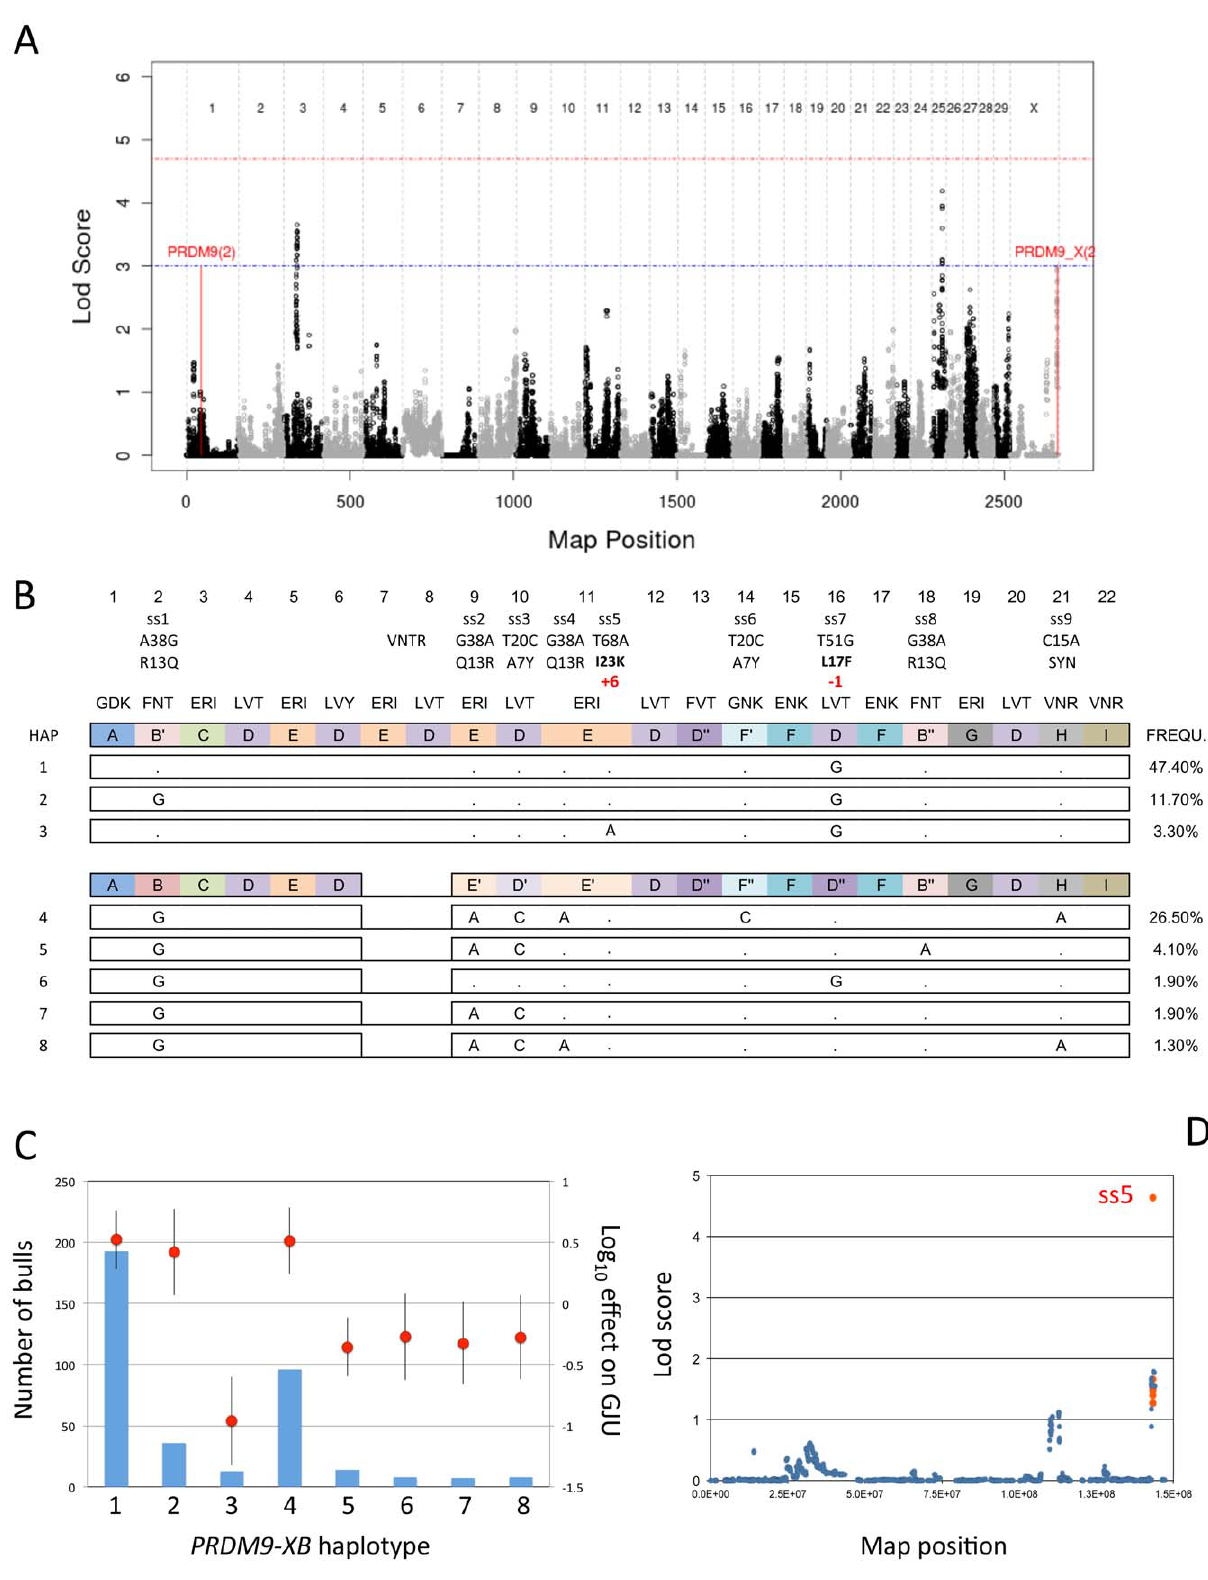
Figure 3. Results of the genome-scan, polymorphisms, observed counts and effects, results of single point analysis. (A) Results of genome-scan for QTL affecting genome-wide jungle usage (GJU) using a method that simultaneously extracts linkage and LD signal [34]. The red and blue horizontal lines mark the genome-wide significant and suggestive thresholds determined by permutation testing. The position of two pairs of PRDM9 parologues, respectively on BTA1 and BTAX, are highlighted. (B) Polymorphisms detected in the ZF array of the PRDM9-XB paralogue. Nine